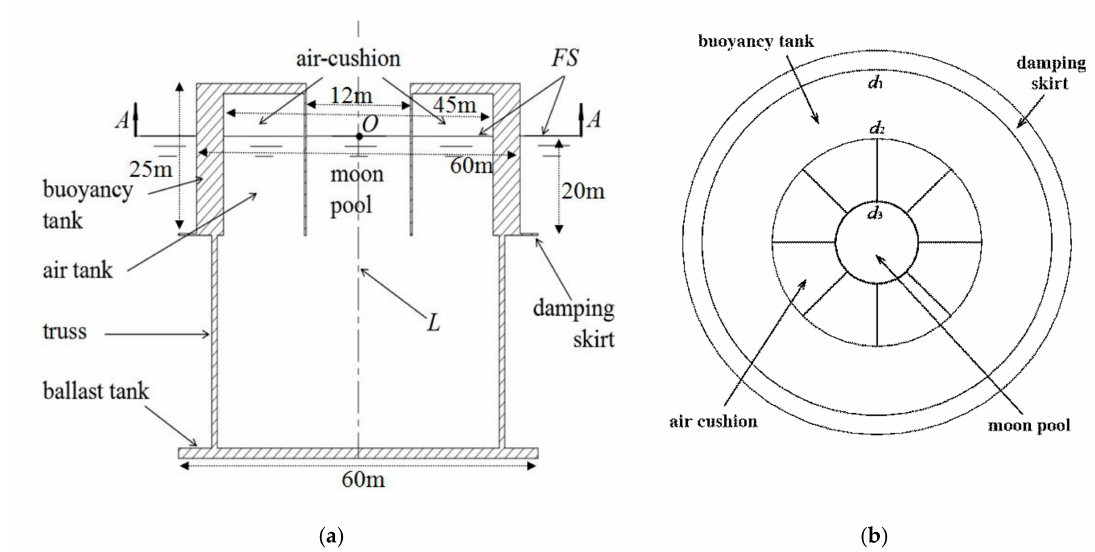
Figure 2. Schematic diagram of the zero-pressurized air-cushion-assisted barge platform. ( a ) Side view; ( b ) top view.